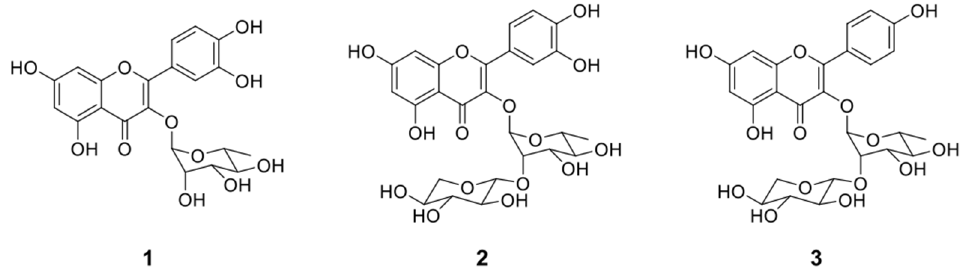
Figure 2. Structure of quercitrin (Compound 1 ), quercetin 3- O - α -L-rhamnopyranosyl-L-(2 → 1)- O - β -xylopyranoside (Compound 2 ) and kaempferol 3- O - α -L-rhamnopyranosyl-L-(2 → 1)- O - β -xylopyranoside (Compound 3 ).